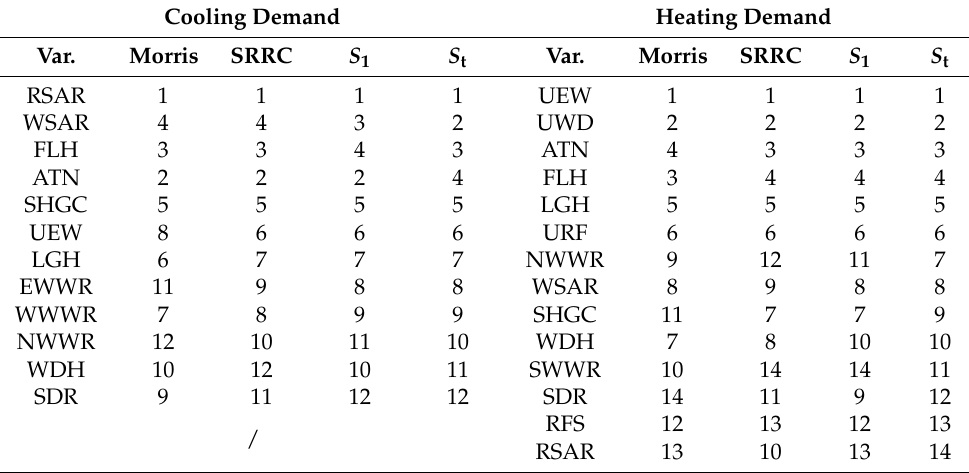
Table 3. The difference comparison of parameter ranking of energy demand given by various methods in the sequential SA